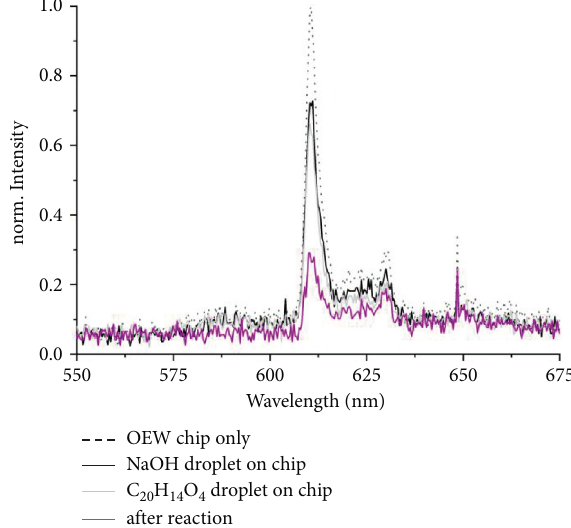
Figure 6: Transmission spectra of the OEW-chip without droplets (black dotted), of the chip with sodium hydroxide droplet (black line), of the chip with the phenolphthalein droplet (gray line), and after reaction of phenolphthalein and sodium hydroxide (purple